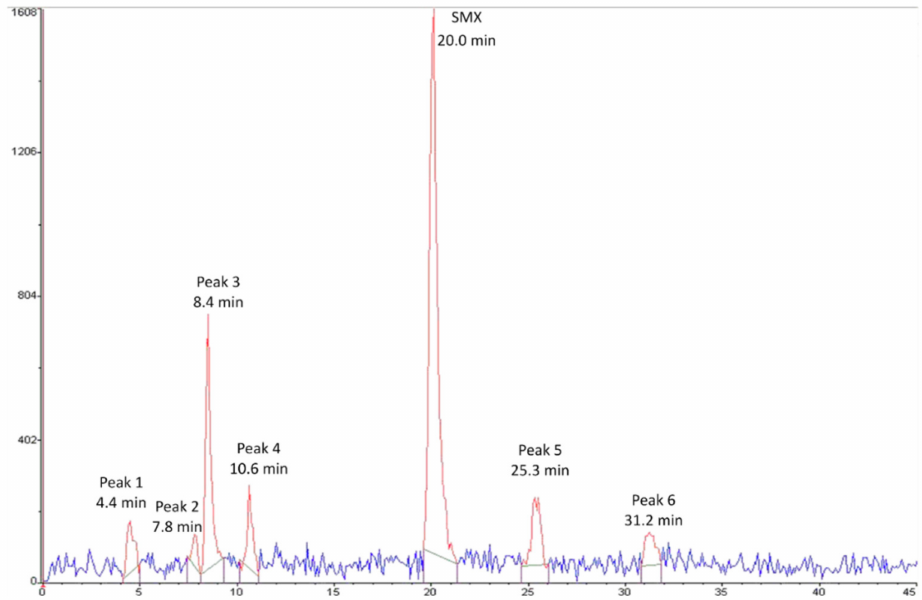
Figure 1. Typical radio-HPLC chromatogram of an extract of well-done cooked meat spiked with 14 C-sulfamethoxazole (SMX). Six potential sulfamethoxazole breakdown products (Peak 1 to 6) can be